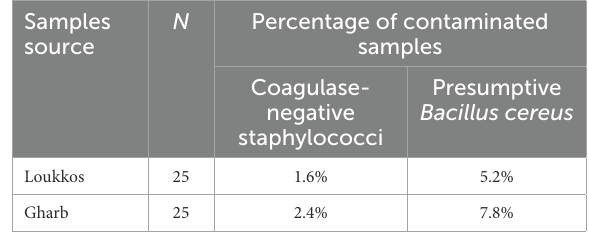
TABLE 4 Prevalence of mold strains contaminating strawberry fruits in the two targeted localities Loukkos and Gharb. Molds species